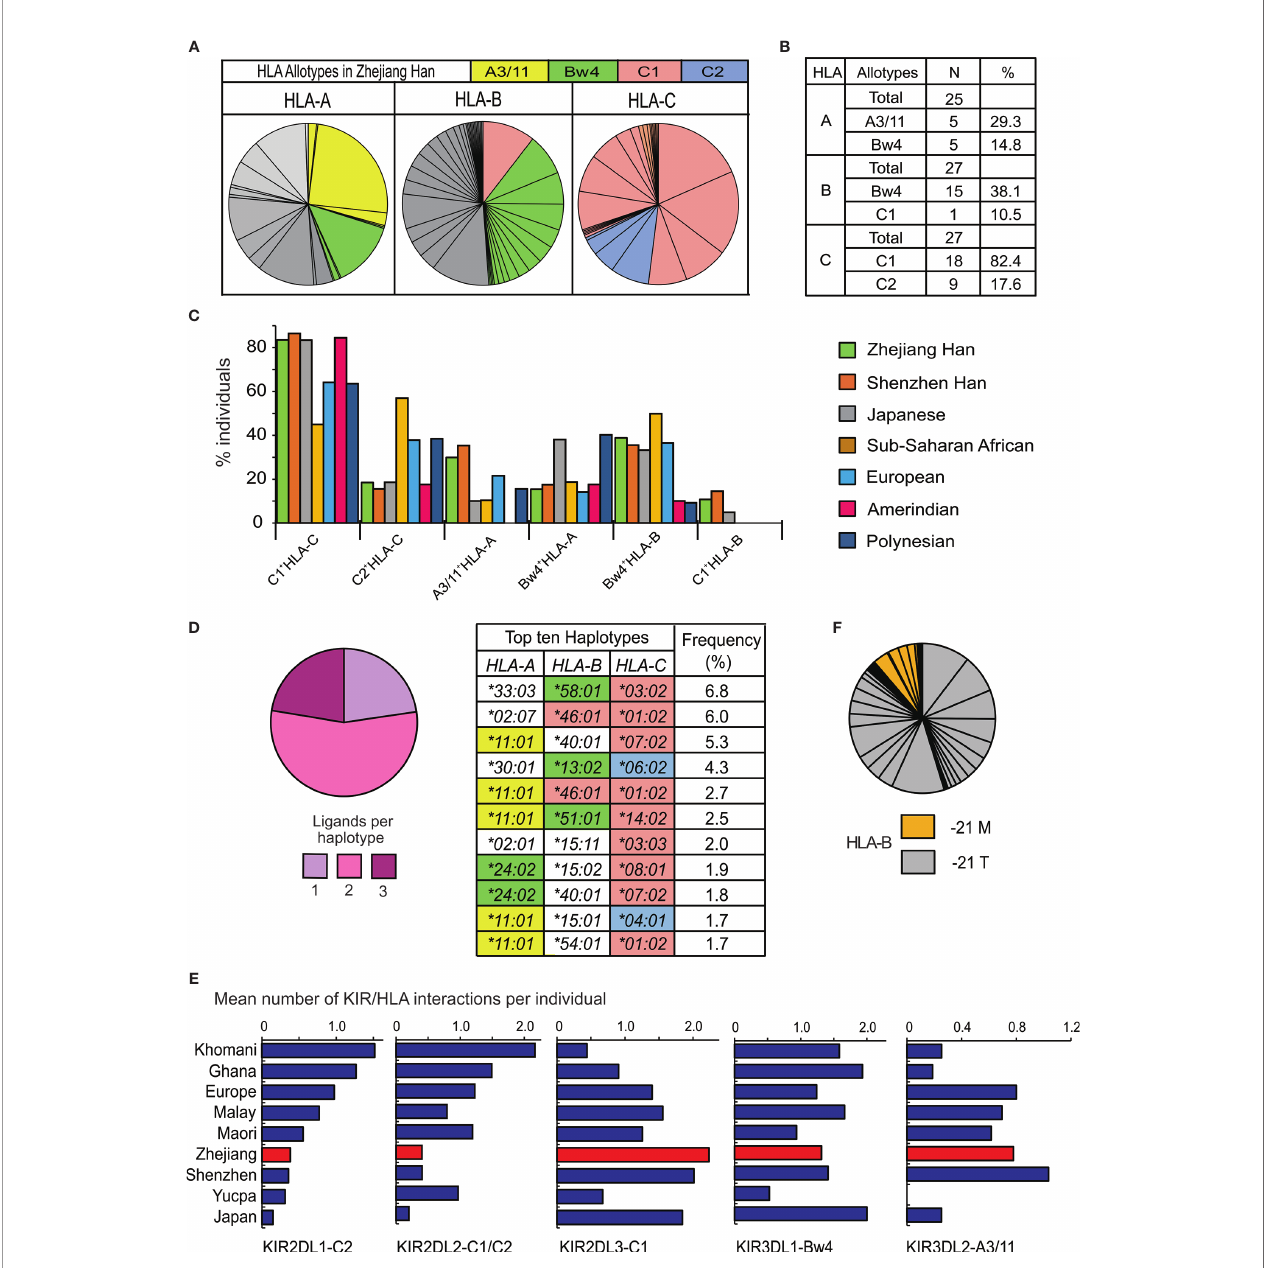
FIGURE 6 | The distribution of HLA in Zhejiang Han. (A) Shown are the frequency spectra of HLA-A , -B , and -C allotypes from 176 Zhejiang Han individuals. Each pie segment represents a distinct allotype (HLA allotype frequencies are given in Supplementary Table 4 ), colored segments signify the allotypes that are KIR ligands: Yellow — A3/11 (HLA-A3 and -A11); Green — Bw4; Red — C1; Blue — C2; Gray — allotypes that are not KIR ligands. (B) Shown are the numbers of distinct allotypes observed and the combined frequencies of A3/11, Bw4, C1, or C2 allotypes for each HLA class I gene. (C) Shown are the distributions of KIR ligands across seven representative populations. The allotype are shown at the bottom. The populations are listed at the right: Chinese Southern Han from Shenzhen, Japanese, South American Yucpa, European, Sub-Saharan African, and Oceania Polynesian (36, 45, 49, 50, 62, 65). (D) (Left) Shown are the combined frequencies in Zhejiang Han of HLA class I haplotypes encoding one (lilac), two (pink) or three (purple) KIR ligands. (Right) the ten most frequent HLA class I haplotypes observed, colored shading indicates HLA class I alleles that encode KIR ligands, as described in panel (A) . (E) Shown is the mean number of distinct interactions per individual observed for each of the inhibitory KIR that interact with polymorphic HLA class I. From left to right: KIR2DL1 interactions with C2 + HLA-C [or with C1 + HLA- C for KIR2DL1*022 allotype (20)] KIR2DL2 with C1 + HLA-B or C, or with C2 + HLA-C; KIR2DL3 with C1 + HLA-B or C; KIR3DL1 with Bw4 + HLA-A or B; KIR3DL2 with HLA-A3/11. The values are shown for nine representative populations: Southern Africa Khomani (34); sub-Saharan Africa Ghanaian (49); European (65); Malay (45); Ma ̄ ori (62); Zhejiang Han; Shenzhen Han (36); Amerindian Yucpa (50); Japanese (37). (F) Shown is the frequency of HLA-B alleles encoding methionine (orange) or threonine (gray) at position -21 in the leader peptide. Each pie segment represents a distinct HLA-B allotype (HLA allotype frequencies are given in Supplementary Table 4